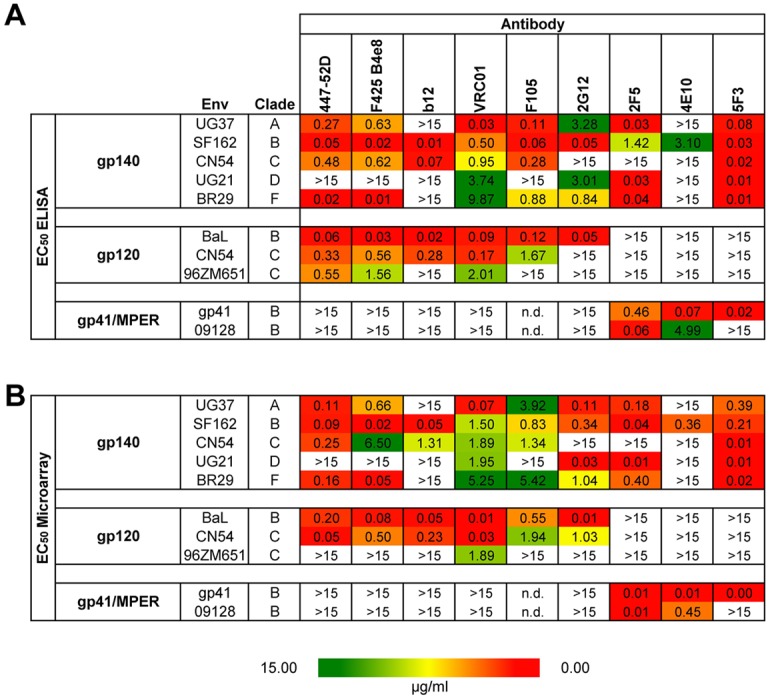
Calculation and evaluation of EC50 data.EC50 values (μg/mL) were generated and calculated (PRISM GraphPad 5.0) by antibody binding curves in ELISA (A) and in the protein microarray chip assay (B). Values were color-coded using red for low, yellow for medium, and green for high EC50 values. No binding is indicated as white boxes. EC50 values of both analyses are representative of two independent experiments.